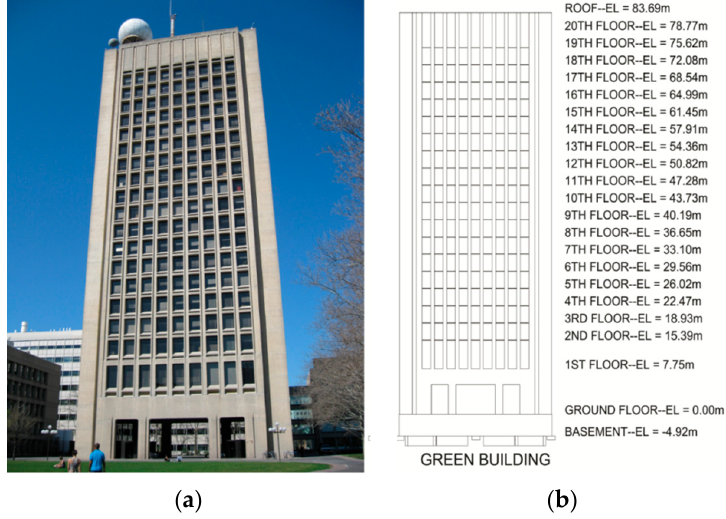
Figure 1. ( a ) Photograph of the Green Building’s south façade; ( b ) Elevation view of the south façade.